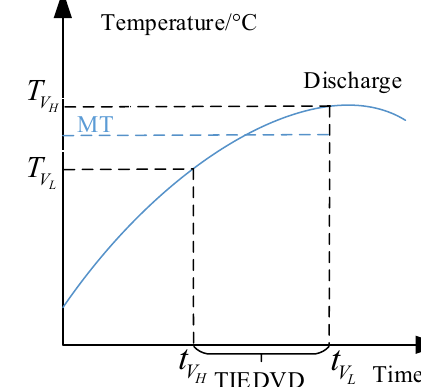
Fig. 3 The definitions of TIEDVD and MT